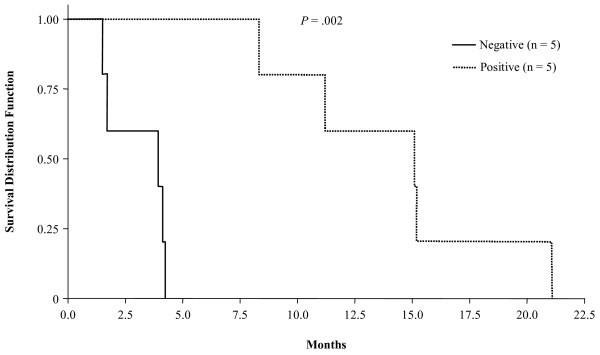
Overall survival of patients enrolled in the study. Positive indicates patients who had evidence of the development of a carcinoembryonic antigen (CEA)- and/or mucin-1 (MUC-1)-specific immune response. Negative indicates patients who did not develop an immune response (n = 3) or who were not assayed (n = 2).